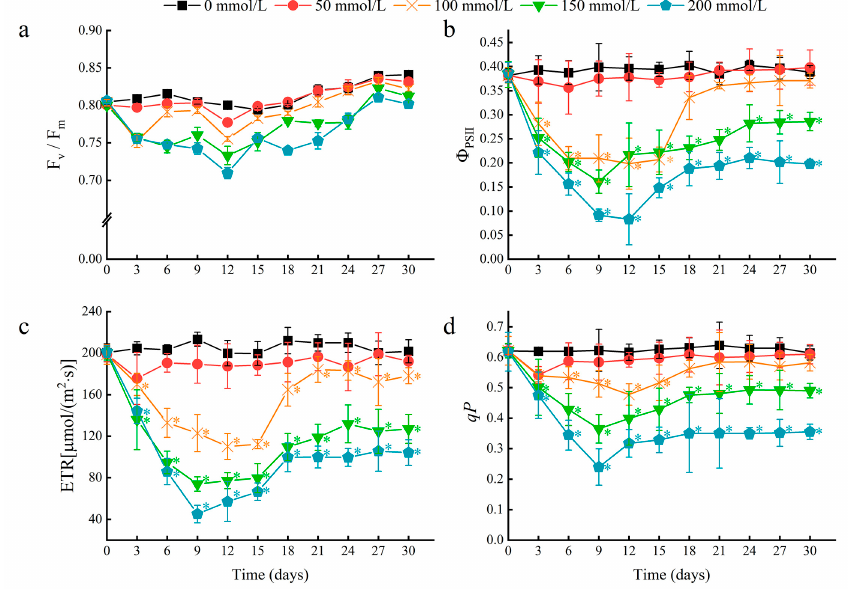
Figure 4. The effects of salt stress on chlorophyll fluorescence parameters in water lily plants. ( a ) Maximum quantum efficiency of photosystem II (PSII) (F v /F m ), ( b ) actual photochemical quantum yield of PSII ( Φ PS II ), ( c ) electron transport rate (ETR), and ( d ) photo-chemical quenching coefficient ( qP ) in water lily plants subjected to salt stress over 30 days. Data are the means of ten biological replicates ( ± SDs). The asterisks represent statistically significant differences ( p < 0.05). Table 1. Sequence statistics of N. ‘Colorado’ under salt